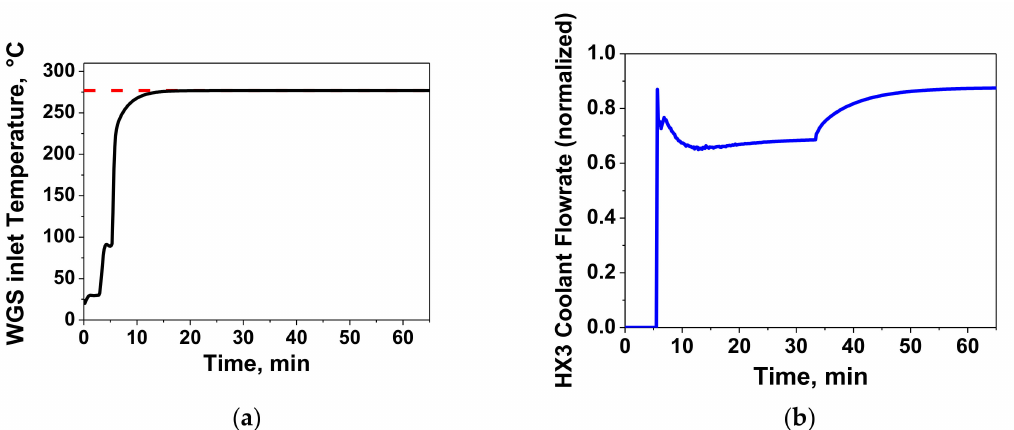
Figure 5. ( a ) Temperature profile of the WGS inlet (TC2 controller) and ( b ) coolant flowrate manipulation at the HX3.